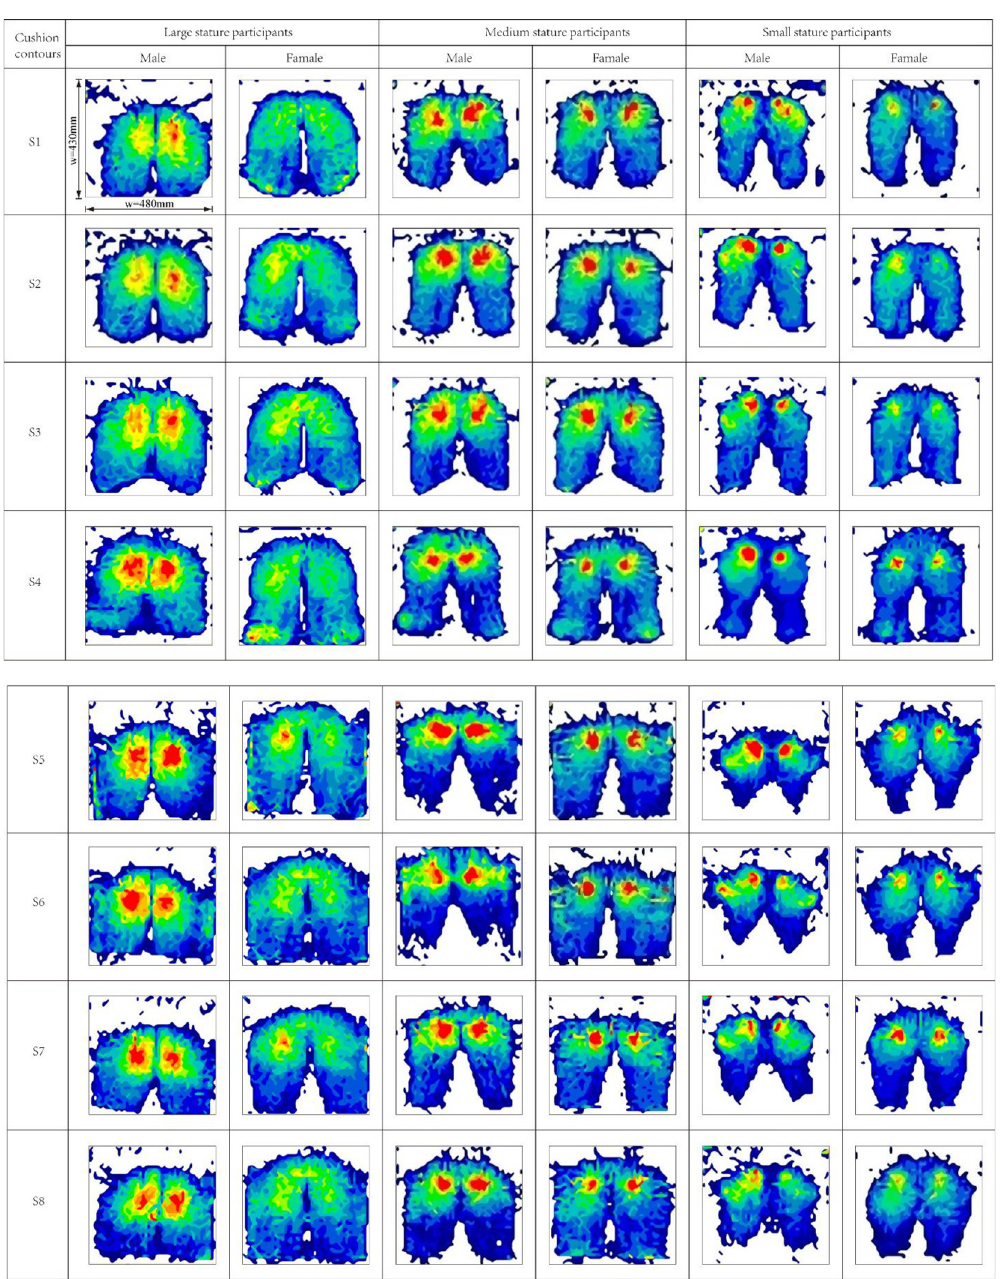
Fig 14. Body-cushion contact pressure distribution cloud